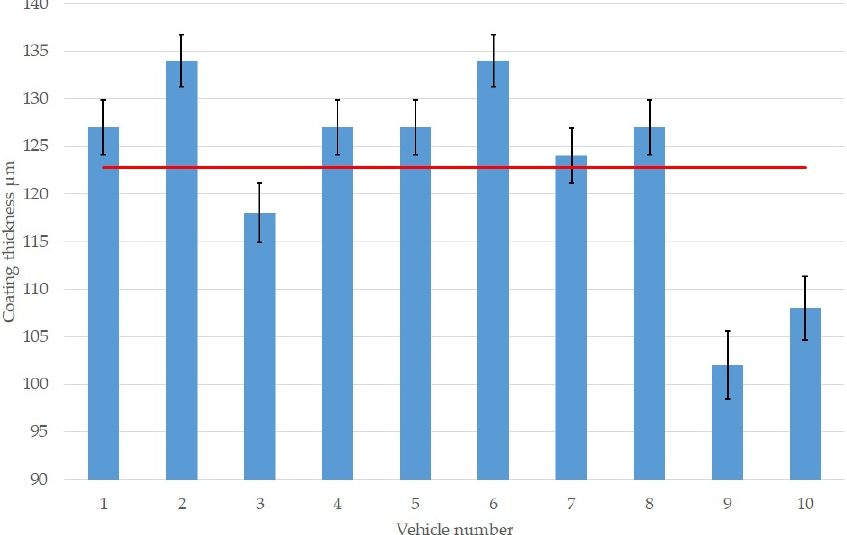
Figure 8. Average c oating thickness on the vehicle rear left fender for delivery vehicle (for all 10 vehicles), by the red line, Figure 8. Average coating thickness on the vehicle rear left fender for delivery vehicle (for all the mean value from 10 vehicles is added. 10 vehicles), by the red line, the mean value from 10 vehicles is